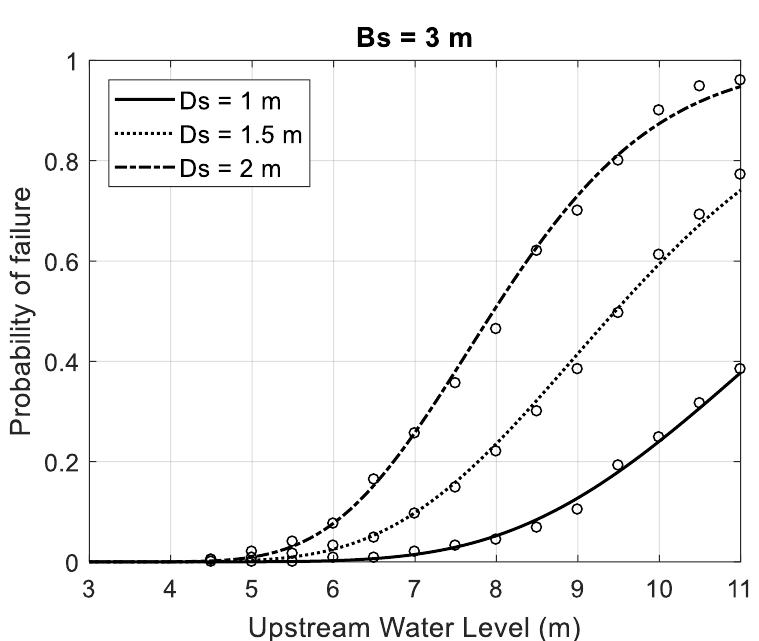
and varying 𝐵 = 2, 3, 4 𝑚 . 𝑠